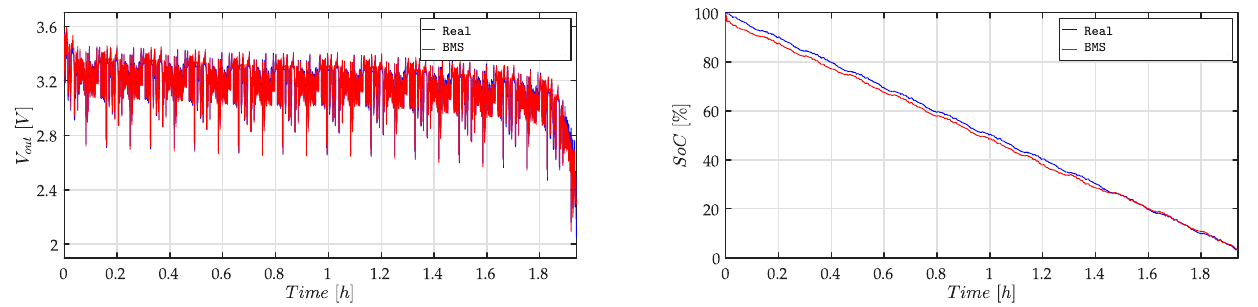
Figure A3. SoC and V out time series referring to the A123-US06 dataset considering the best PI-ENNC BMS model on the test set.